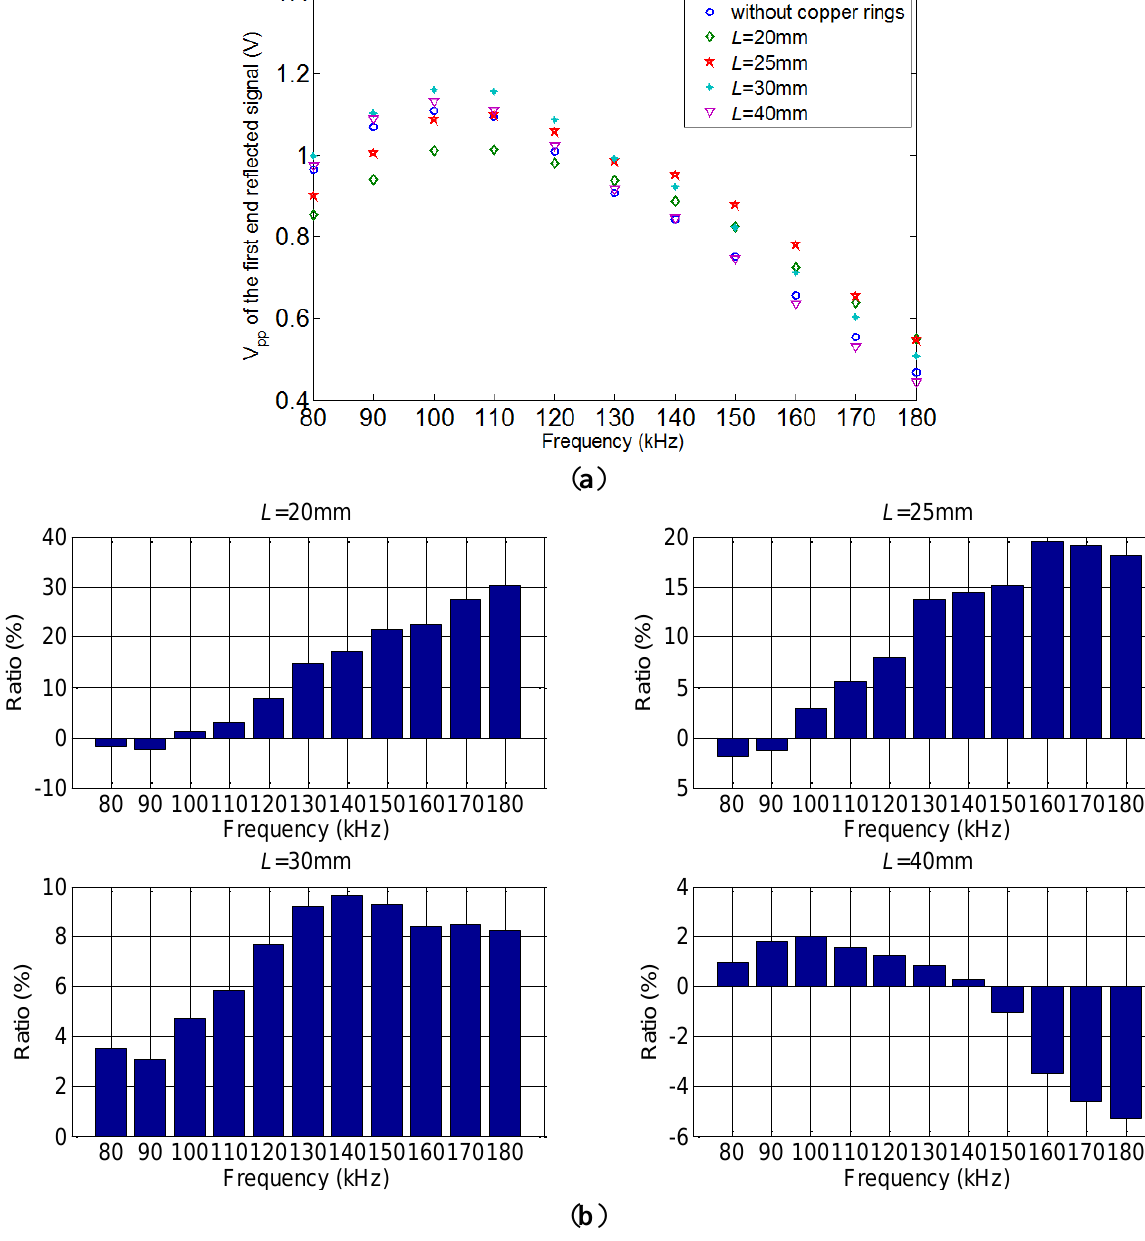
Figure 17. The experiment results of pipe A. ( a ) The peak to peak amplitudes ( V first end reflected signals under five conditions. ( b ) The relative enhancement ratios of compensated V with four different L , compared with the conventional pp